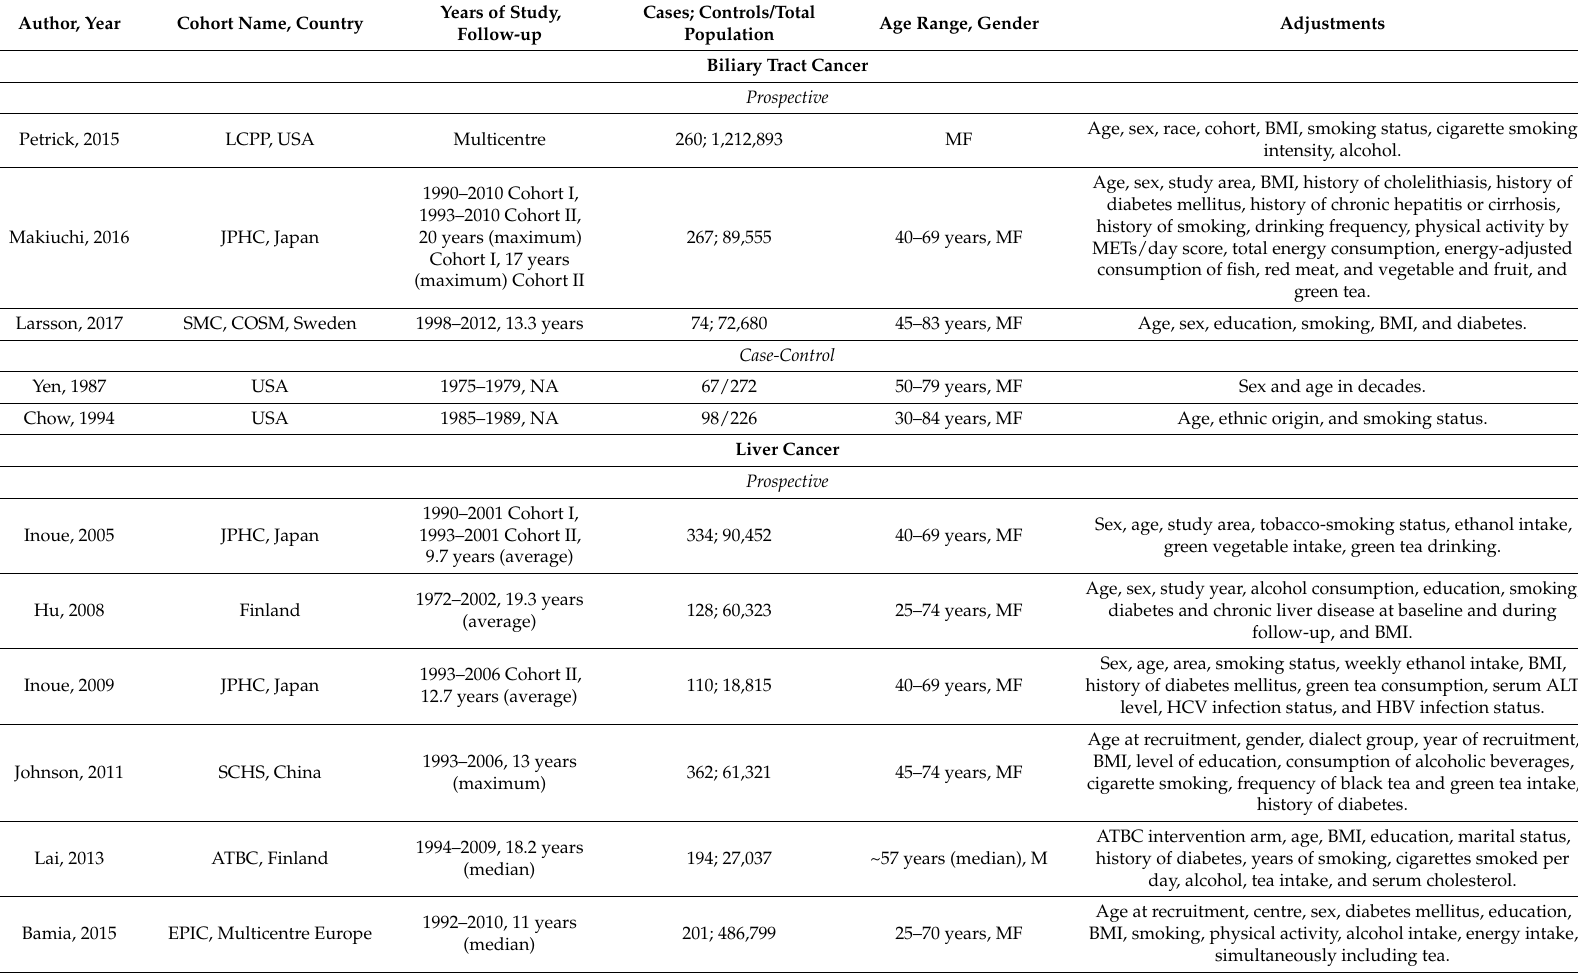
Table 1. Characteristics of the studies included in the